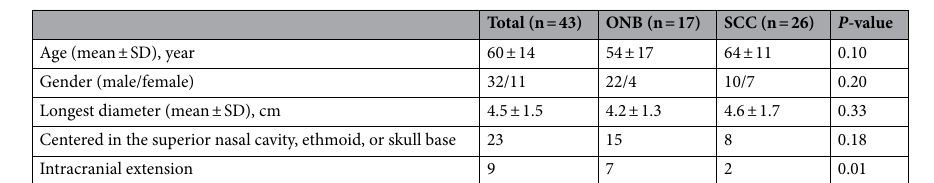
Table 1. Patient and tumor characteristics of olfactory neuroblastoma and squamous cell carcinoma. ONB olfactory neuroblastoma; SCC squamous cell carcinoma, SD standard